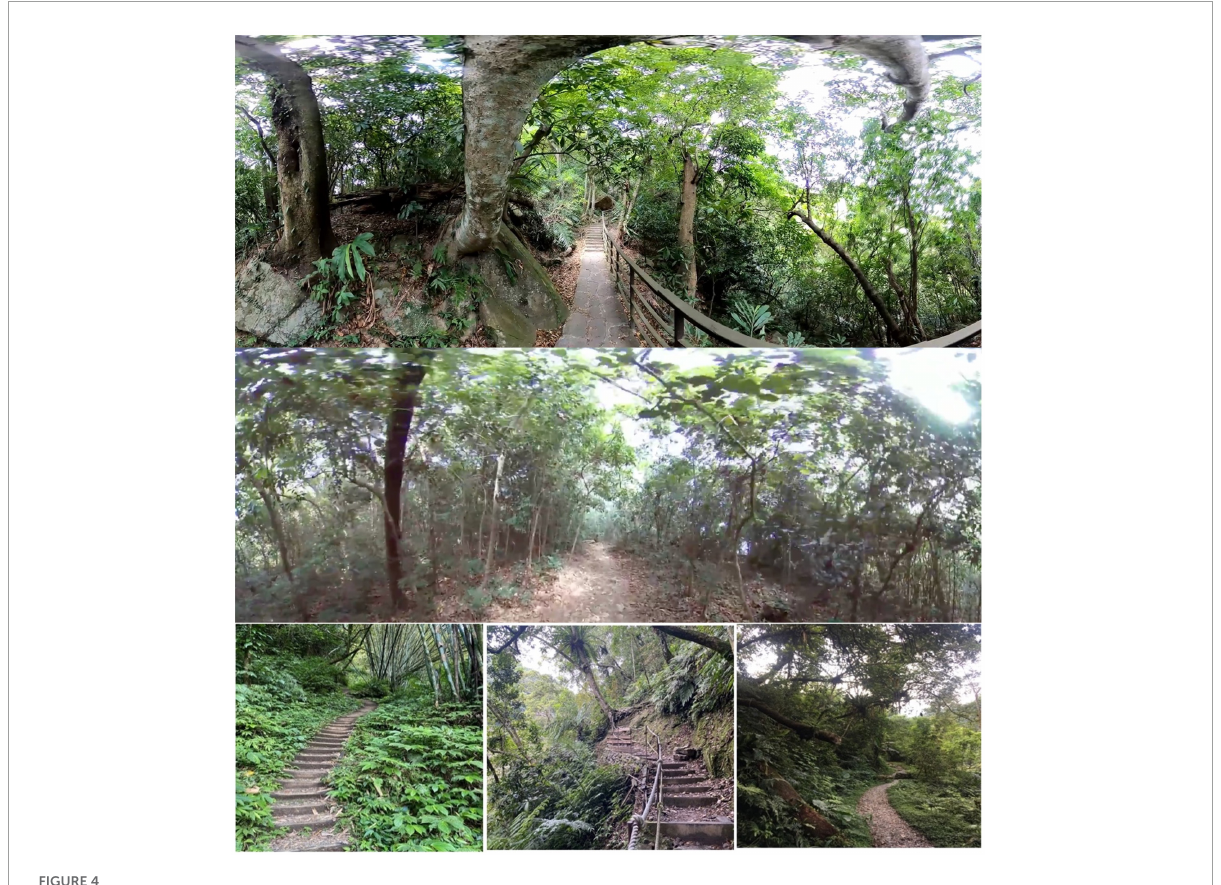
FIGURE4 The source image of panoramic video.